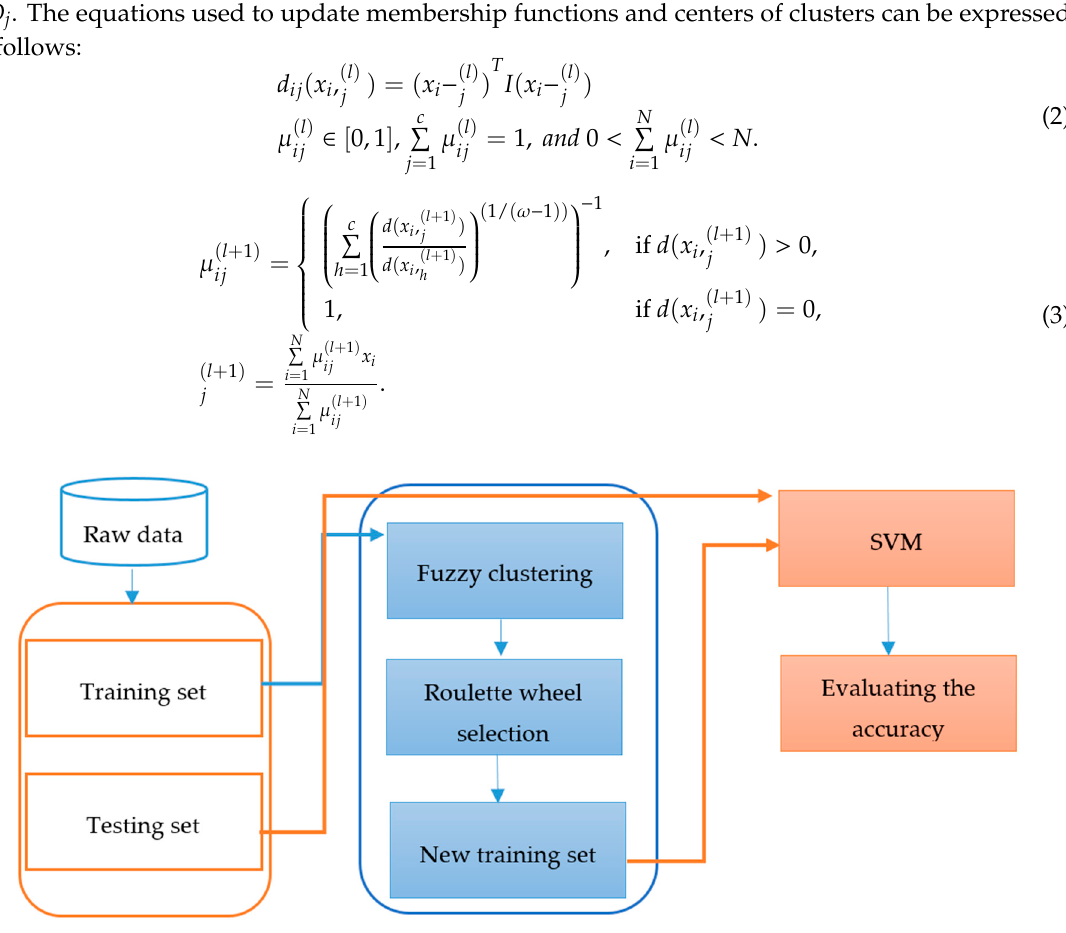
Figure 1. An illustration of the proposed support vector machine with new fuzzy selection (SVMFS)